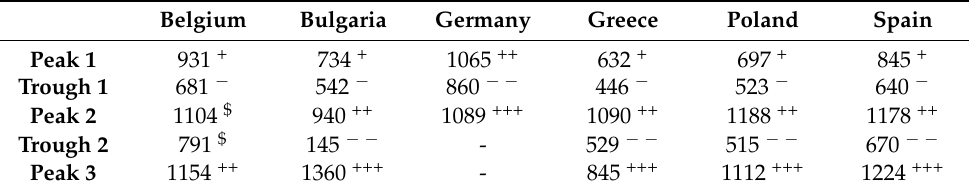
Table 3. Number of steps in significant peaks and troughs during